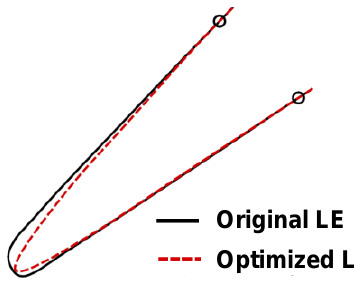
Figure 1. New leading-edge shape proposed in [4].